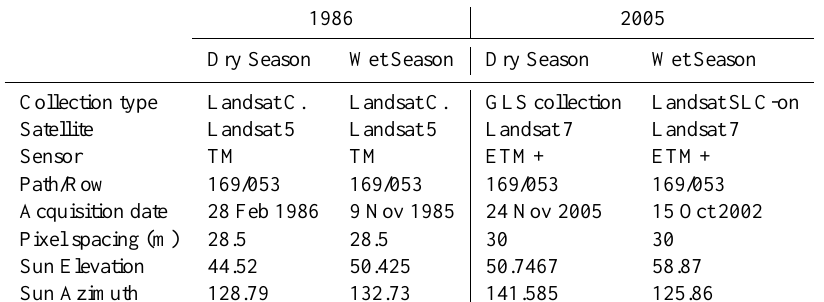
Table 1. Description of Landsat images used.